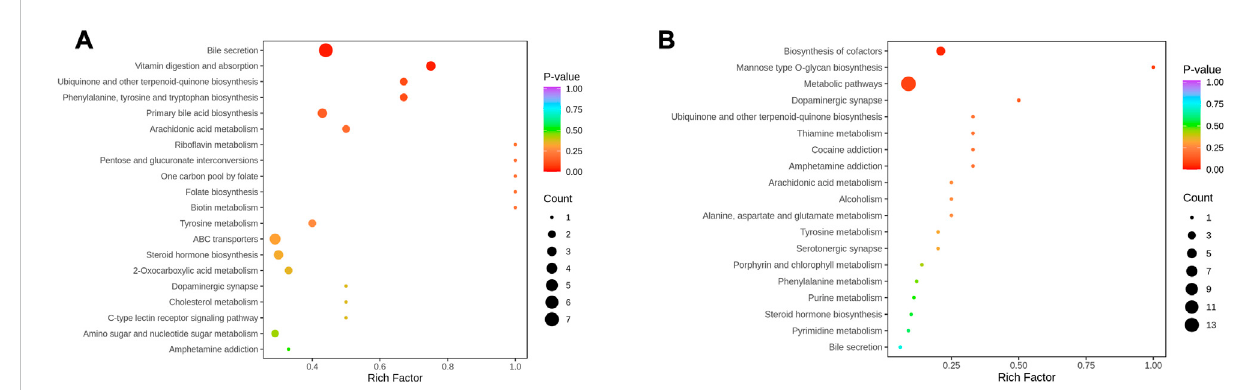
FIGURE 8 KEGGEnrichmentanalysisofdifferentialmetabolites. (A) :NCvs.A; (B) Avs.B;thedot ’ scolouristhe p -value.Theredderitis,themoresigni fi cantthe enrichment is. The dot size represents the number of differential metabolites in the pathway enriched).